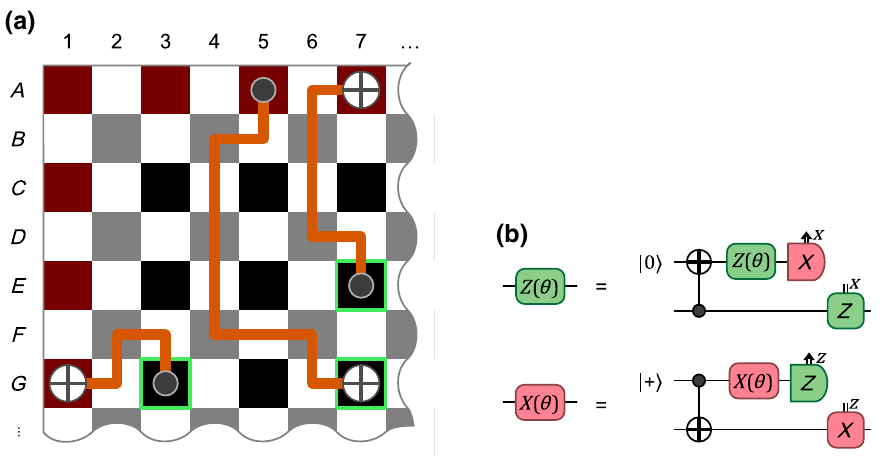
FIG. 10. We assume the capability of performing S and T gates at the boundary qubits (red) where it is easy for us to supply the requisite S and T magic states. We can then execute S or T gates in the Z or X basis for our circuit by using long-range CNOT gates and the circuits in (b). For example, to execute S or T on qubits G 3, E 7, and HTH on G 7, we apply long-range CNOT gates between pairs ( G 3, G 1 ) , ( E 7, A 7 ) , ( A 5, G 7 ) , and then execute S or T on G 1, A 7, HTH on A 5. We can continue applying other Clifford gates to qubits G 3, E 7, and G 7 right after performing the long-range CNOT gate, without waiting for the Z correction, since we can propagate the correction through Clifford